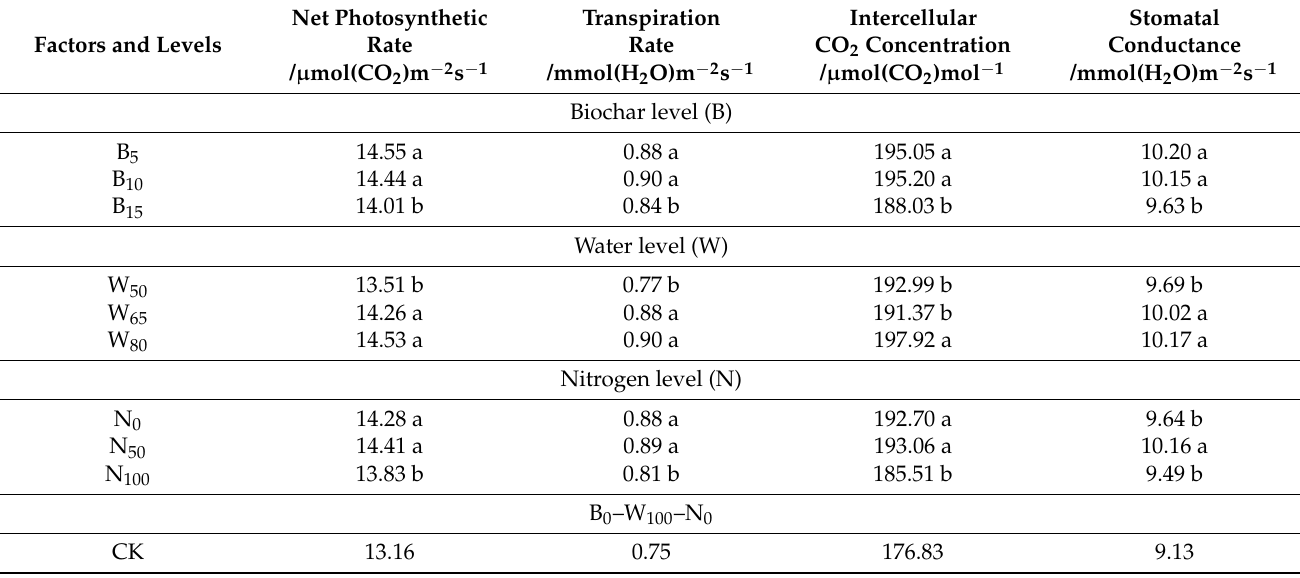
Table 5. Leaf gas exchange parameters of cucumber